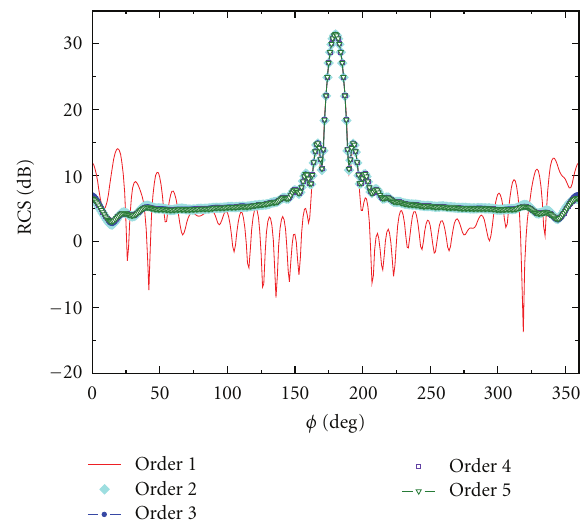
Figure 4: Comparison of the results with di ff erent orders of basis.